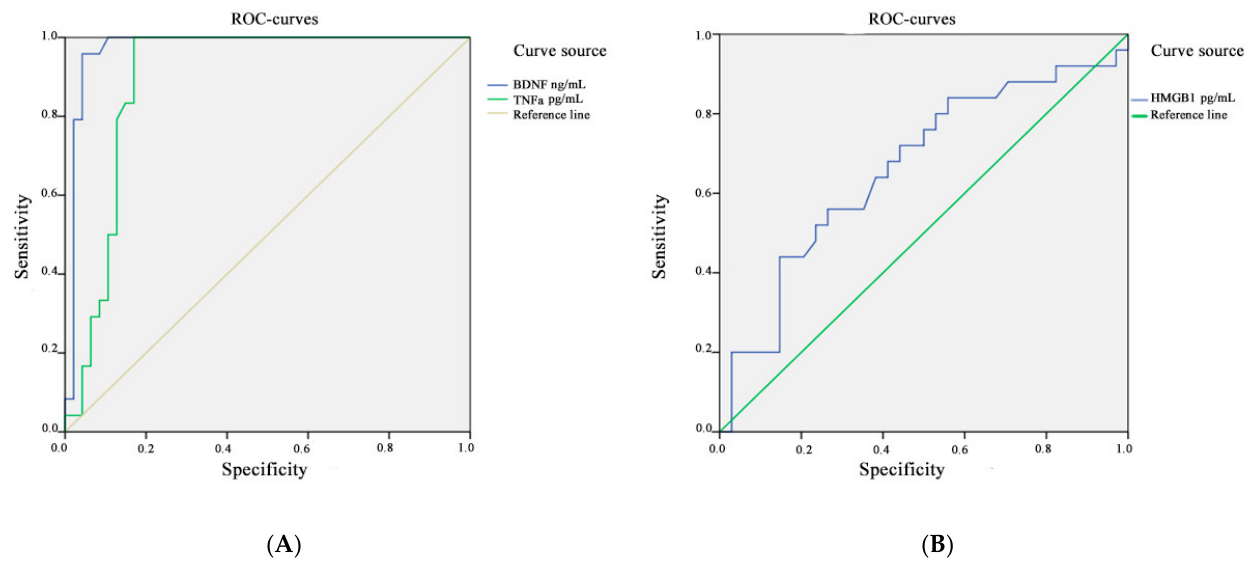
Figure 3. ROC analysis for the concentration of BDNF and TNFa ( A ) and HMGB1 ( B ) in the blood plasma of patients with TLE and in the control group. Table 4. Area under the ROC curve with standard error and 95% confidence interval .